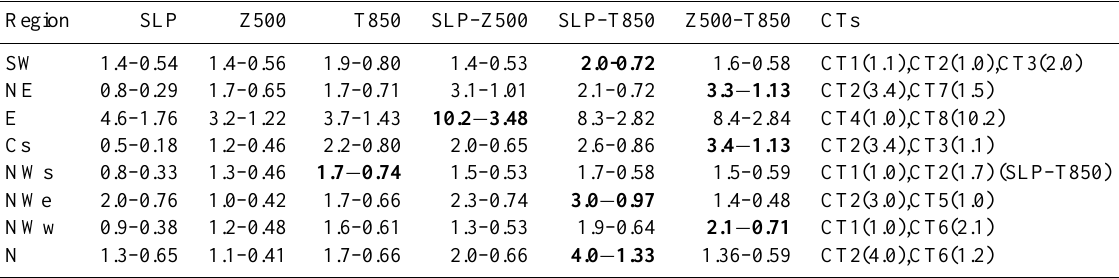
Table 3. Dispersion of the EIs (see main text for the definition of the index). The numbers denote the range–standard deviation of the EIs obtained for each region and CT classification. The last column shows the CTs with EIs (in brackets) above 1 for the best classification of each region (bold numbers).